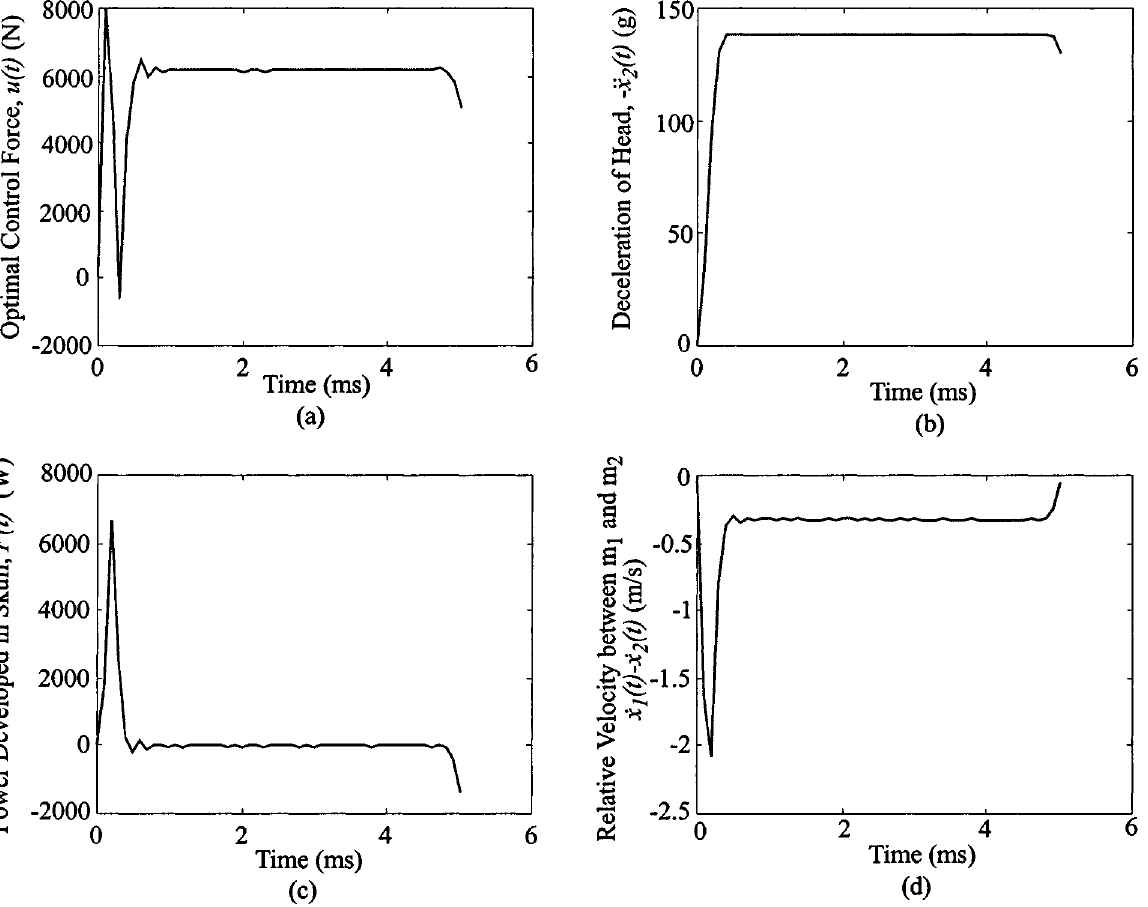
Fig. 11. Optimal control force and system responses. Case 1: Minimize the peak head acceleration, S 0 = 15 mm, E 0 = 100 J, A–P direction.